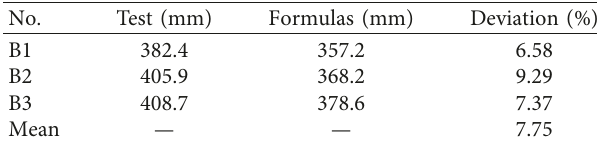
Table 4: Comparison of the ultimate loads of the SCCTB specimens.